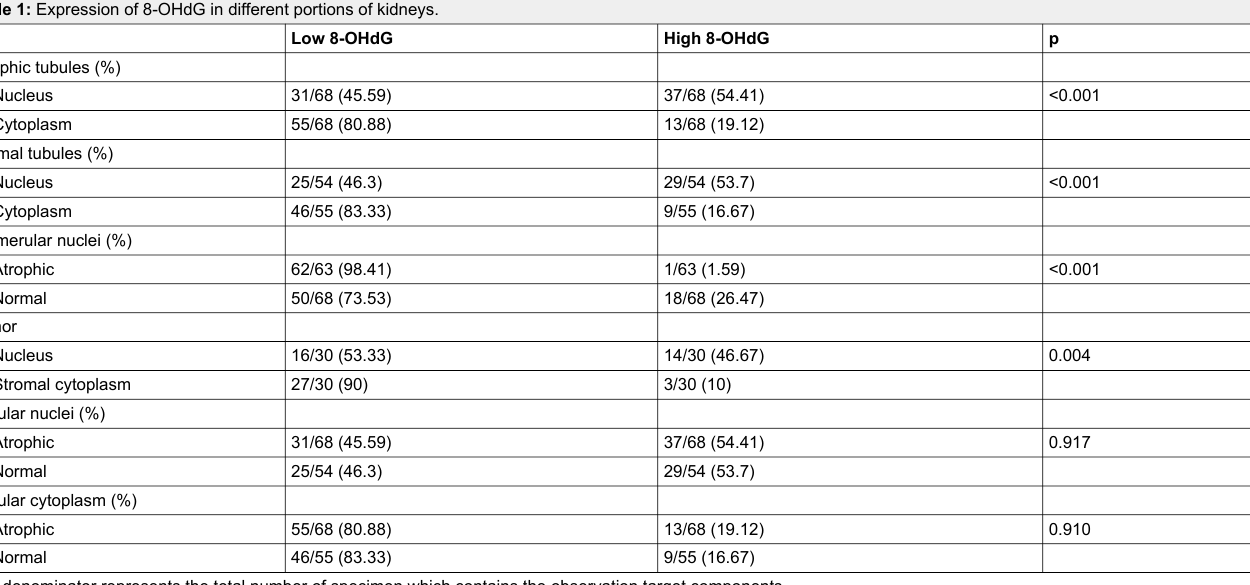
Table 2: Characteristics of patients divided by low or high renal interstitial or glomerular fibrosis score.